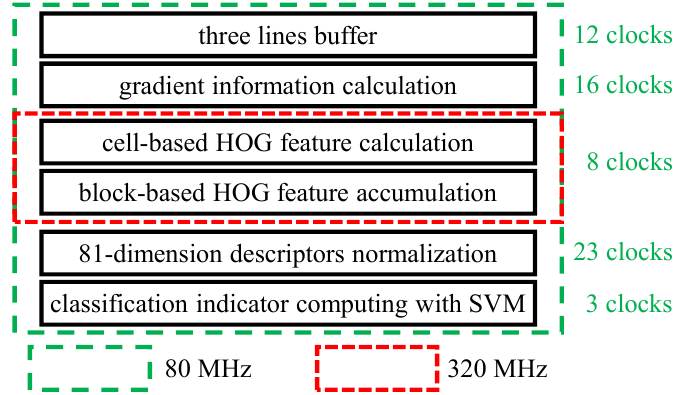
Figure 1. The entire processing procedure of the previous